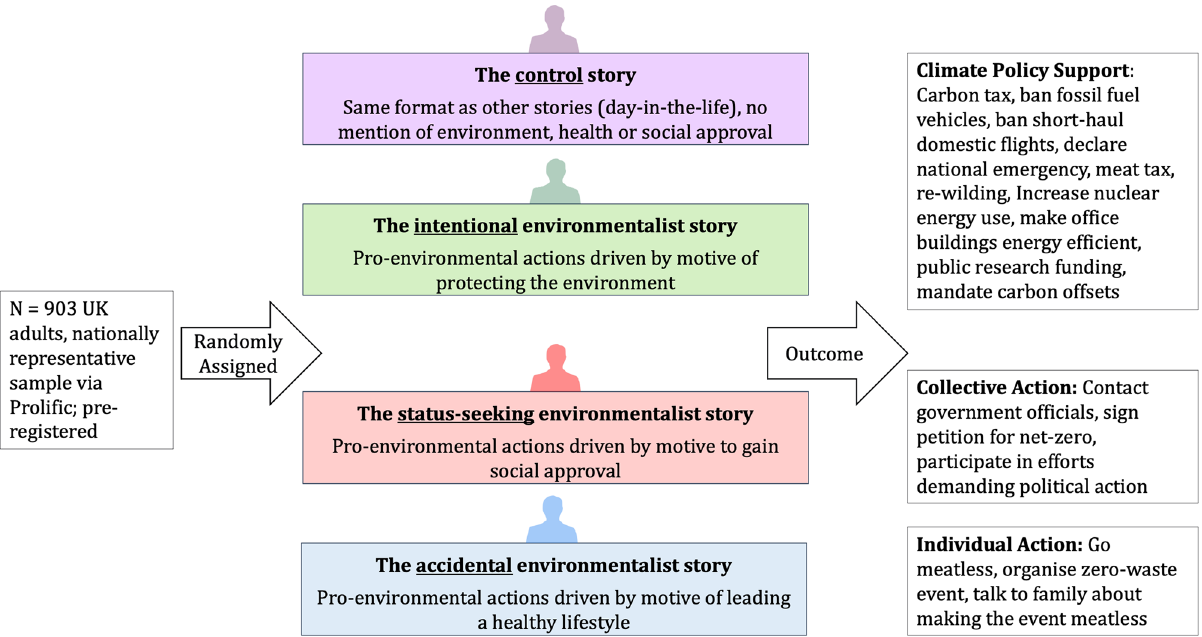
Figure 1. Experimental set-up. The sample was nationally representative of the UK with regards to age, gender and ethnicity; recruited via Prolific Academic; randomly assigned to one of three experimental conditions or